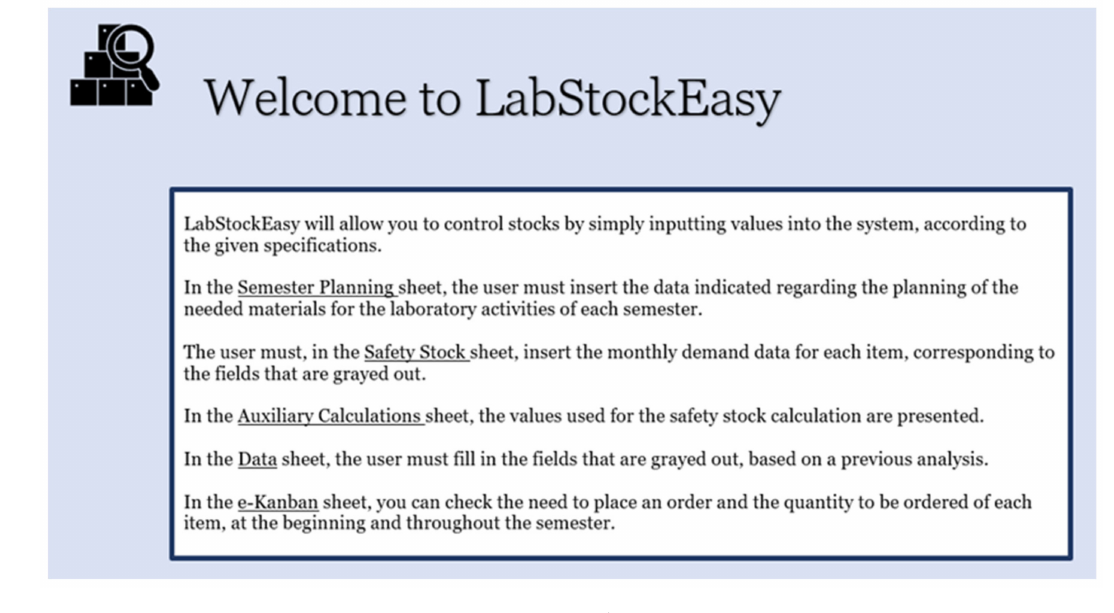
Figure 5. Decision support system’s home page.